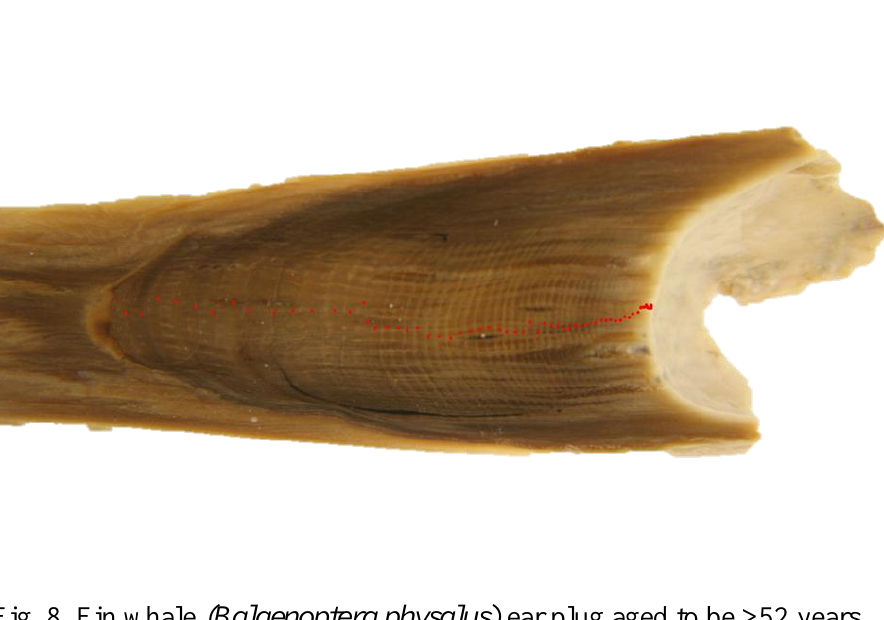
Fig. 8. Fin whale (Balaenoptera physalus ) ear plug aged to be >52 years showing the neonatal line, GLGs becoming more compacted with age and a transition of GLGs at ca. 14 years. Photo courtesy of Sverrir Daniel